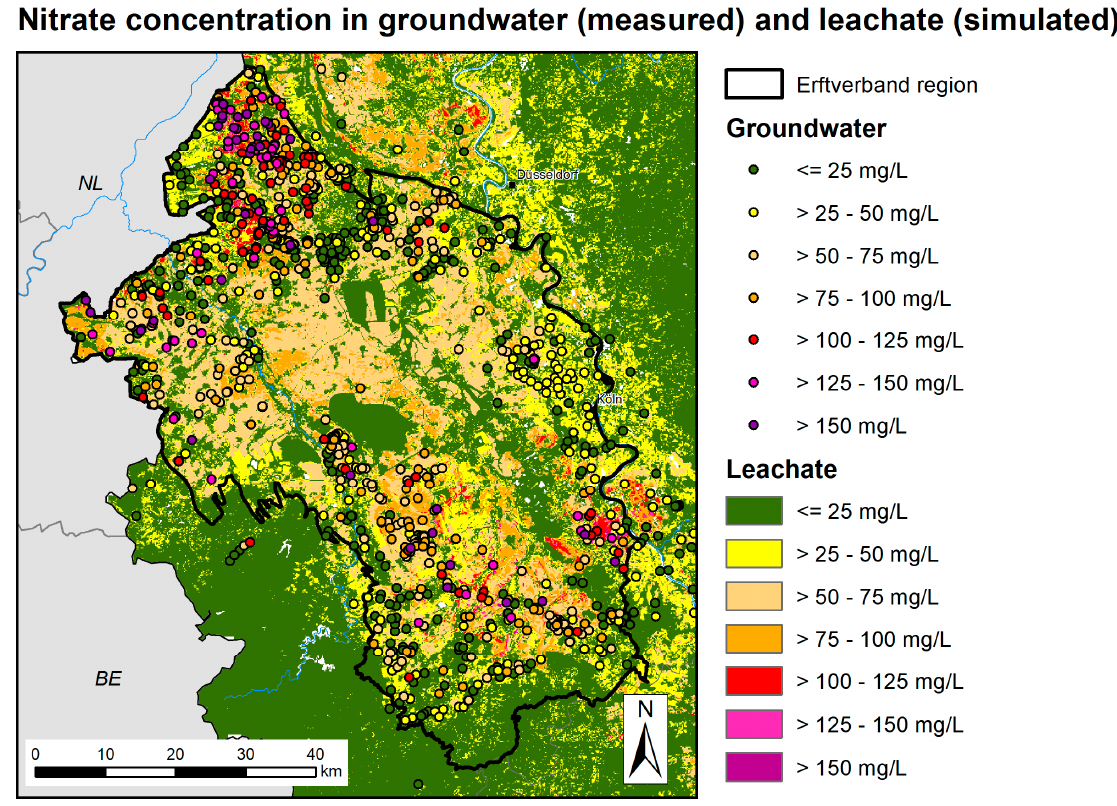
Figure 9. Spatial representation of class widths of modelled nitrate concentrations in leachate with measured nitrate concentrations in groundwater in the area of responsibility of the Erftverband.